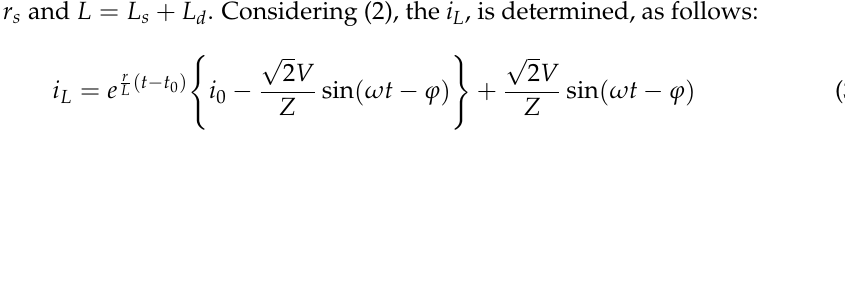
where r = r s and L = L s + L d . Considering (2), the i L , is determined, as